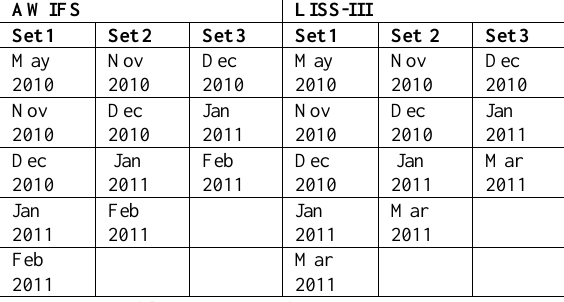
Table 2: AWIFS and LISS-III Datasets IRS-P6 LISS-III data are well suited for agricultural and forestry monitoring. LISS-III (IRS-P6) time-series multi- registered against the fine resolution images. The characteristic of the AWIFS and LISS-III sensor have been mentioned in Table 3. The spatial pixel ratio between classification image AWIFS and testing image LISS-III is 1:3, means that the one